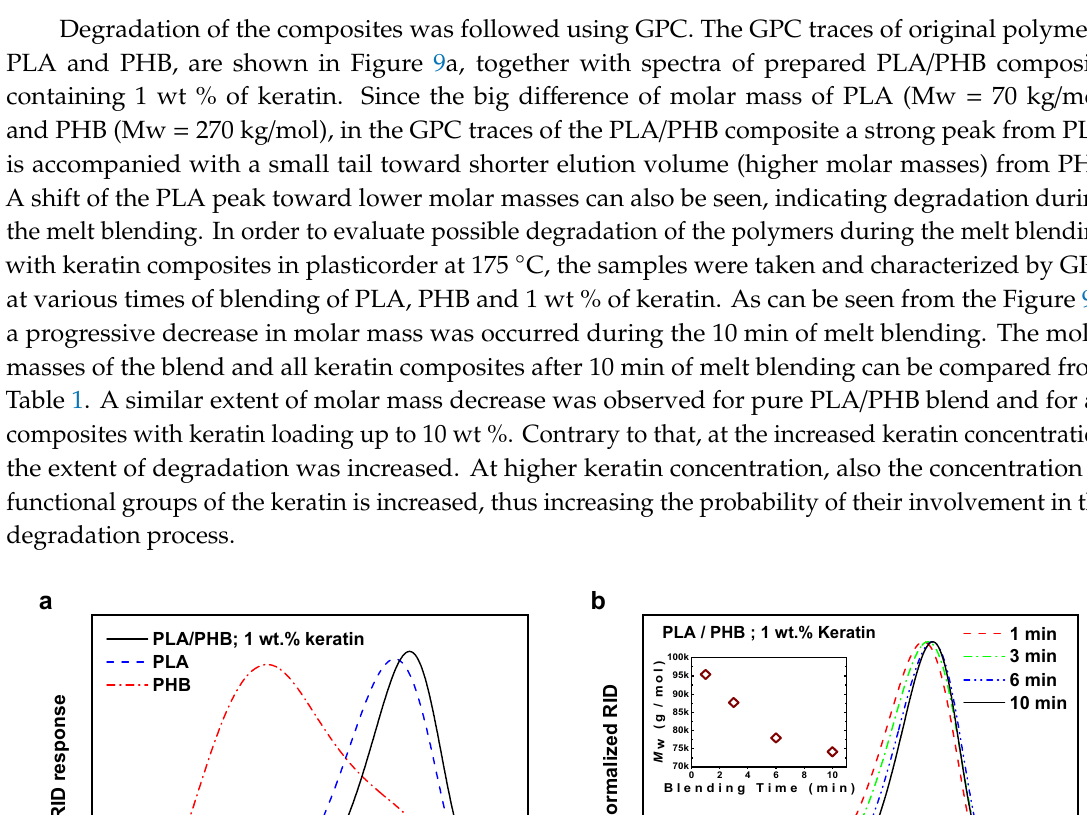
Figure 8. Scanning electron micrograph of: ( a ) PLA/PHB blend, ( b–f ) PLA/PHB/ATBC composites with different keratin content. Micrographs are labelled according to keratin content, i.e., b , c , d , e , f contain 1, 3, 5, 10 and 20 wt % of keratin, respectively. SEM images were taken at 500× ( right side ) and at 1000× ( left side ) magnification. Arrows in the left micrographs show some of the visible aggregates of the keratin.